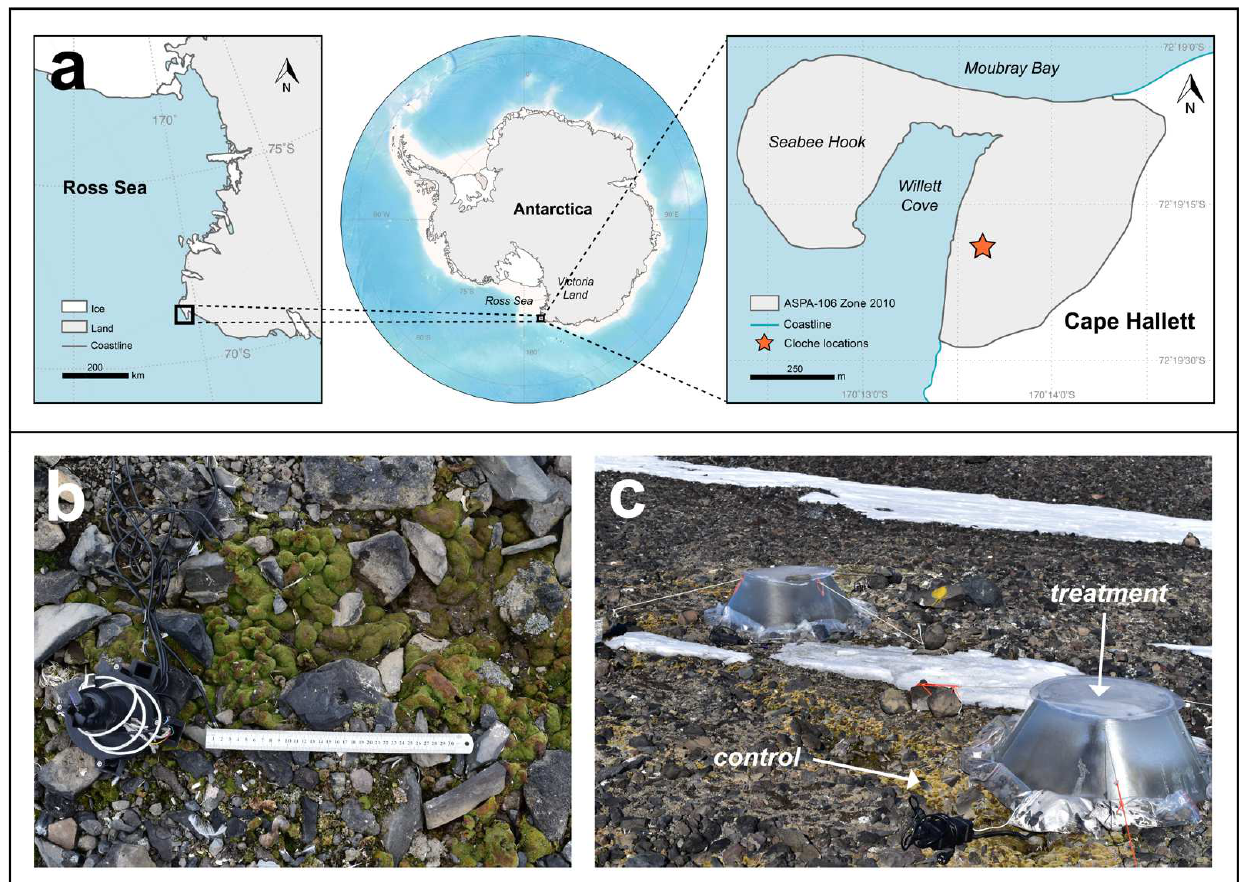
Figure 1. Study site location and chamber setup. ( a ) Cape Hallett location on the Ross Sea coastline in northern Victoria Land, Antarctica. ( b ) Bryum argenteum var. muticum occurs in large patches (30 cm ruler as reference). A heating device equipped with a temperature sensor and ground temperature probe (on the left) was used to control the climate in the chambers used for the warming experiment. ( c ) Two chambers were set up and secured to the ground. Mosses inside the chambers represent the treatment samples and mosses outside the chambers were the control samples.